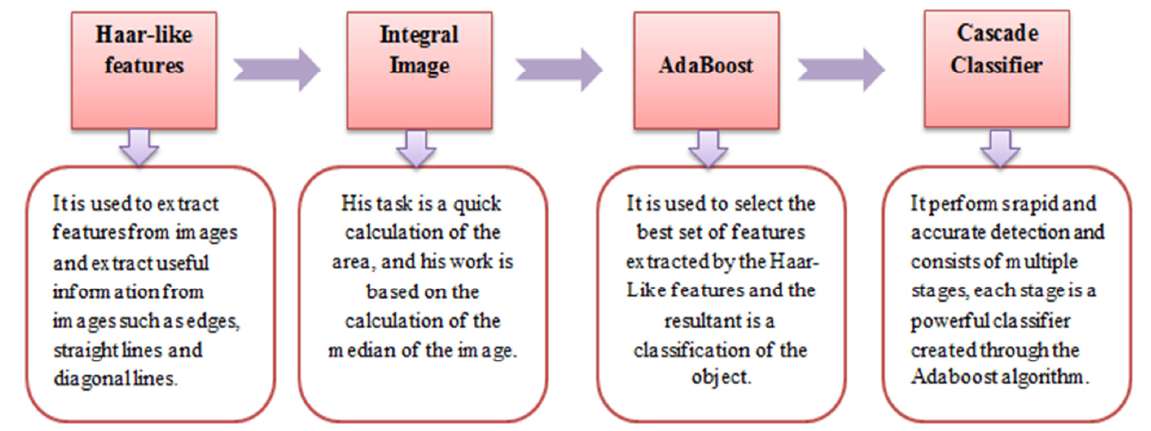
Fig. 4. General Architecture of Viola-Jones